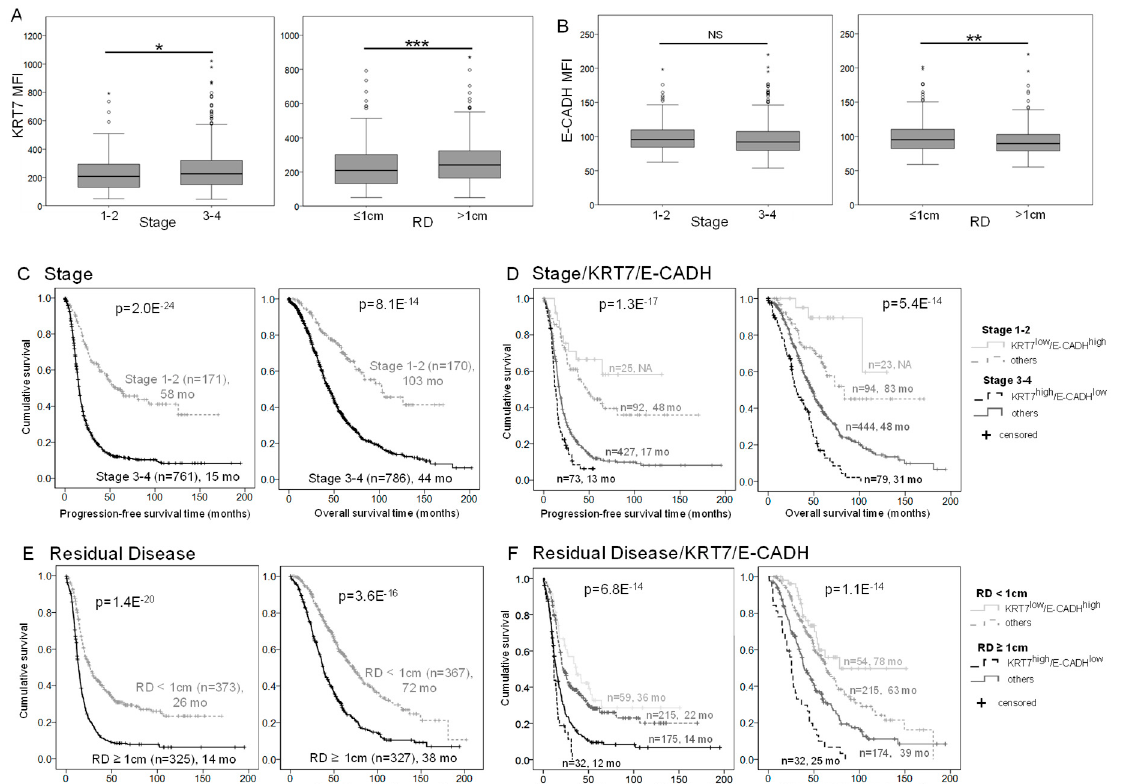
Figure 5. KRT7 and E-CADH combination improves prognosis evaluation of patients stratified by residual disease and stage. ( A , B ) KRT7 ( A ) and E-CADH ( B ) expression by early (1 and 2) or late (3 and 4) stage and by level of residual disease at surgery (low RD ≤ 1 cm or high RD > 1 cm). Boxes represent the interquartile (IQ) range and whiskers represent the highest and lowest values, which are less than 1.5 times the IQ range. Outliers are 1.5 times (circle) or 2 times (star) the IQ range. The non-parametric Mann-Whitney test was used to compare the means (* = p < 0.05; ** = p < 0.01; *** = p < 0.001). ( C – F ) Kaplan–Meier curves of stage ( C ), stage/E-CADH-KRT7 combination ( D ), RD ( E ), and RD/E-CADH-KRT7 combination ( F ) associations with progression-free survival (left) and overall survival (right). MFI measured expression of KRT7 and E-CADH was dichotomized by the 75th percentile into groups of low and high expression, and the groups of patients were categorized as indicated in the legends. p values are indicated. Number of patients and estimated median survival months (mo) are indicated for each group (NA = not